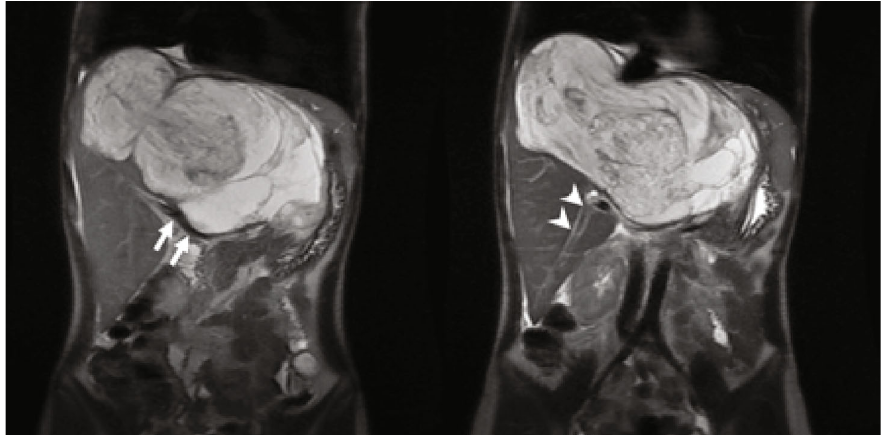
Figure 1: MRI T2-weighted coronal view, showing the huge heterogenous liver mass. The hepatic pedicle (arrows) and segment 6 pedicle (arrowheads) were not involved by the tumor.